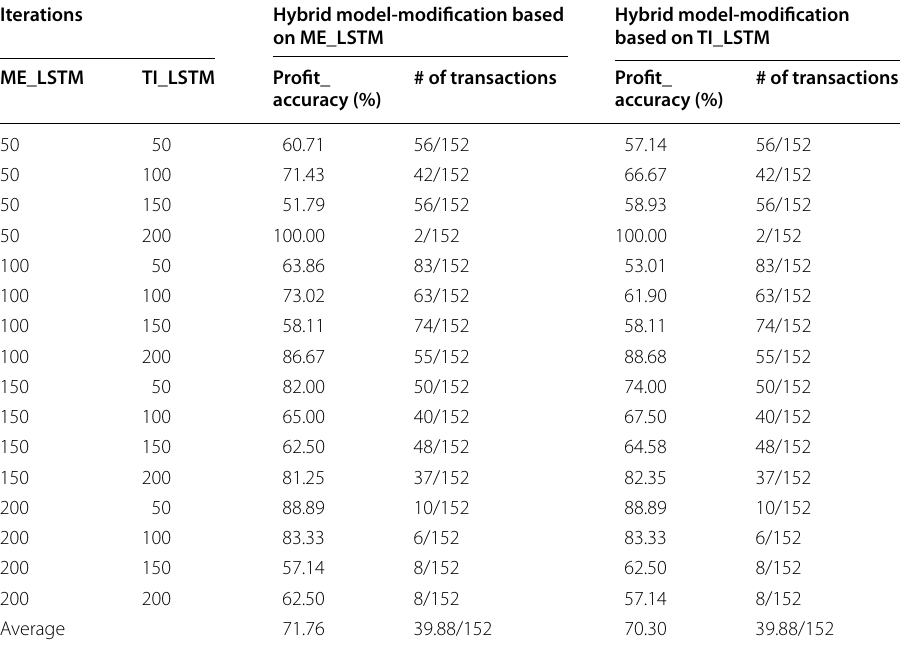
Table 18 Hybrid model (on extended dataset): three‑days‑ahead predictions Iterations